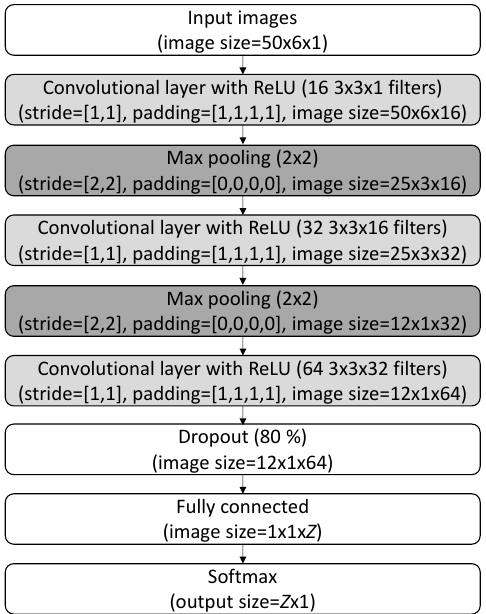
10 of 21 Figure 6. The process of producing the input image to the convolutional neural network: ( a ) a normalized continues wavelet transform, sampled pixels are overlaid, ( b ) the constructed image. The convolutional neural network of this study has three convolutional layers and two max pooling layers (see Figure 7). The two types of layers are alternatively arranged to gradually reduce the height and width of the images while increasing their depth (i.e., the number of channels). The last convolutional layer is followed by a dropout layer followed by a fully connected layer and a softmax layer. The purpose of these layers is to prevent overfitting, dimensionality reduction, and classification, respectively. All convolutional layers pad a zero pixel in all four directions (i.e., left, right, top, and bottom).